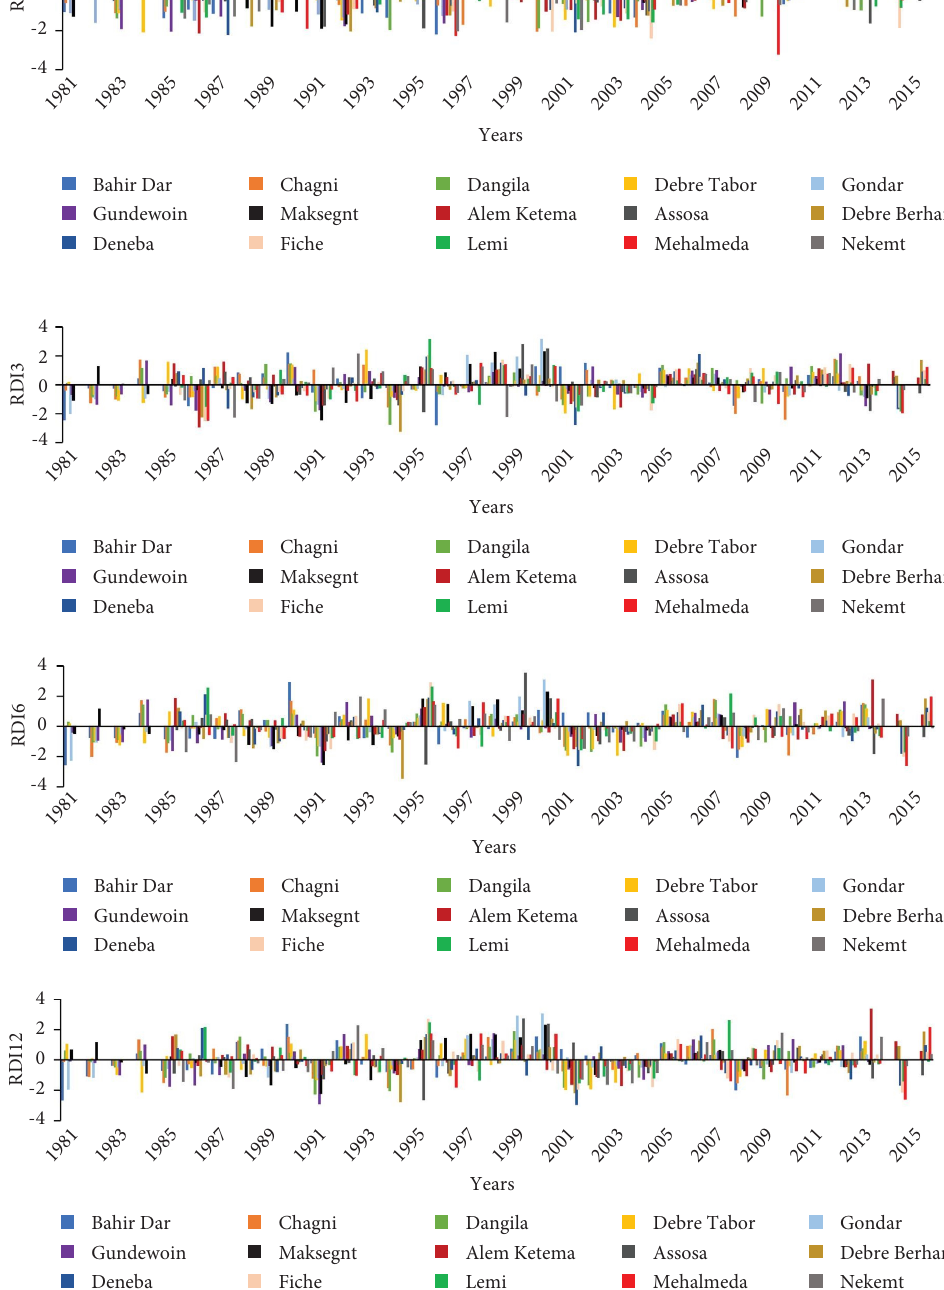
Figure 5: Meteorological drought time series in Abbay river basin using